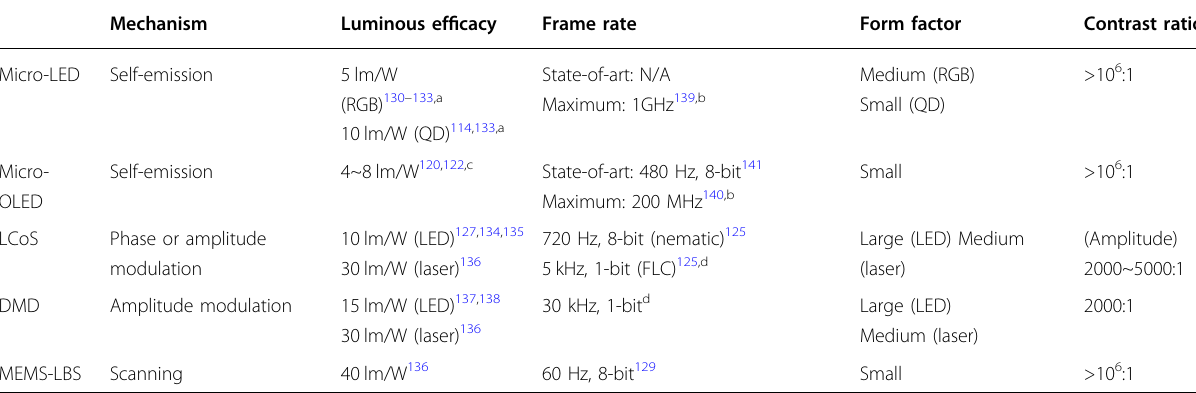
Table 1 Summary of performance parameters of different light engines Mechanism Luminous ef fi cacy Frame rate